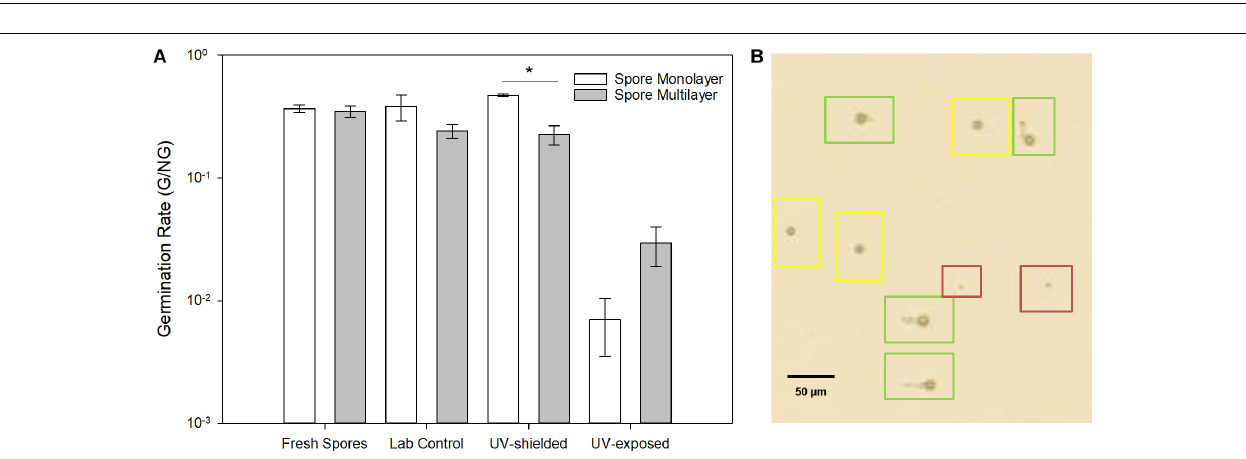
FIGURE 7 | Metabolic activity upon revival, after exposure to Mars simulated conditions aboard the MARSBOx payload. Metabolic activity is depicted as percentage of reduced resazurin. (A) S. shabanensis (B) S. capitis subsp. capitis . (C,D) A. niger spores in monolayer (C) and in multilayer (D) .